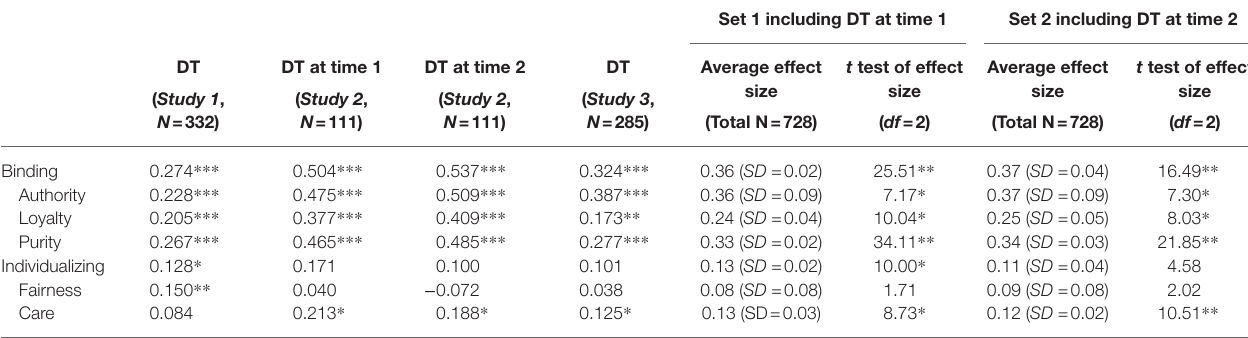
Set 1 including DT at time 1